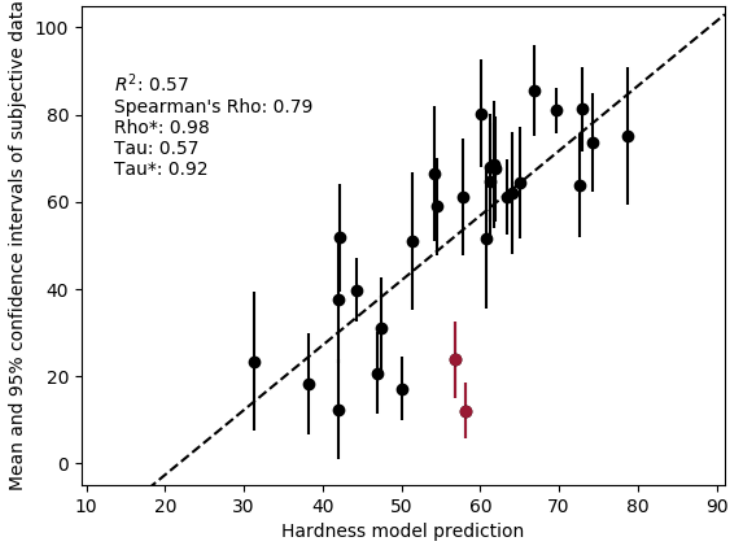
Figure 9. Performance of the hardness model with the between-source-type validation